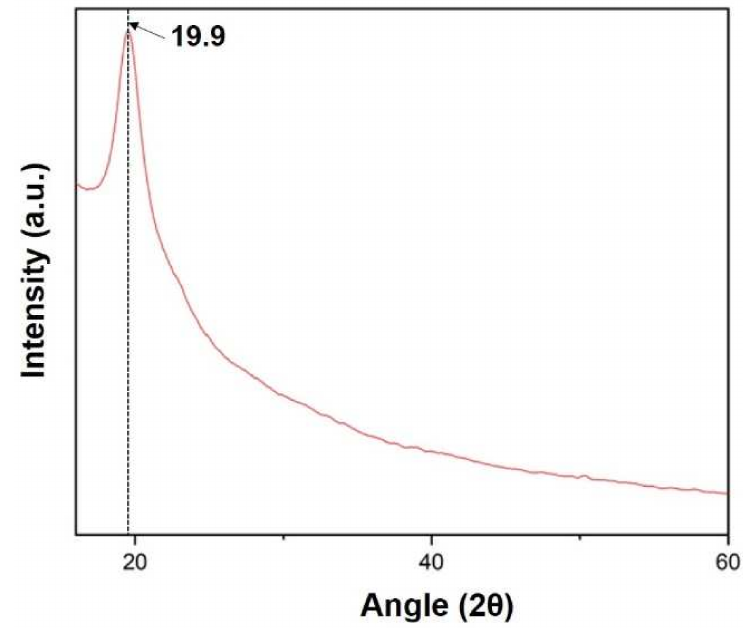
Figure 10. XRD spectra of the prepared silk fibroin film.